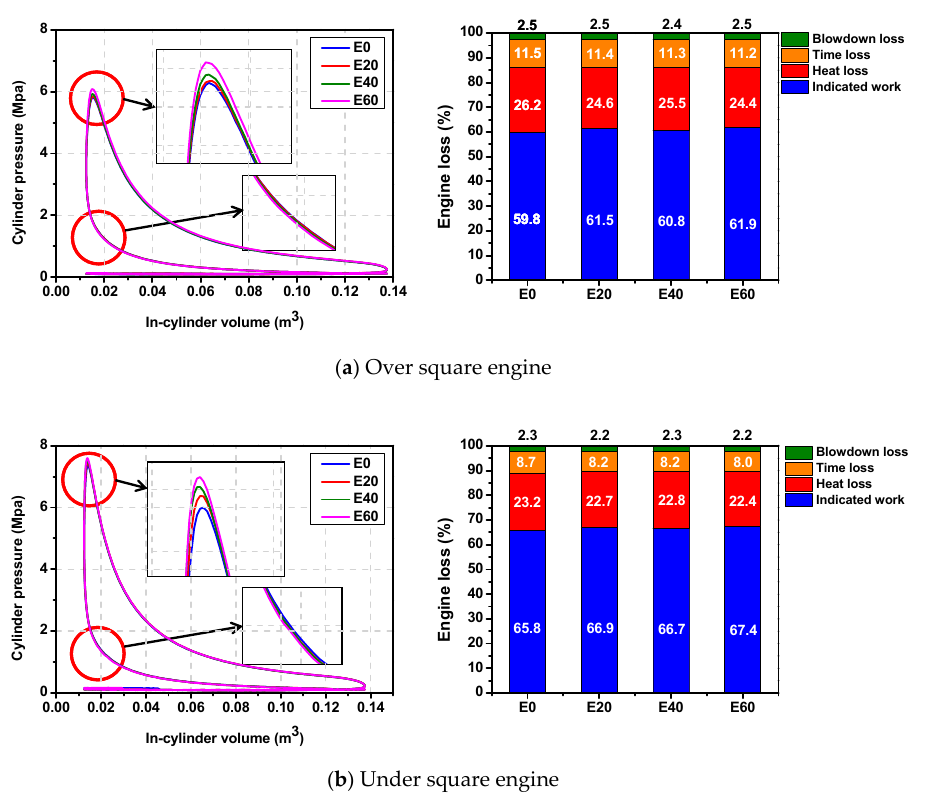
Figure 9. The P–V diagram and three engine losses for over and under square engines and ethanol blending ratio.